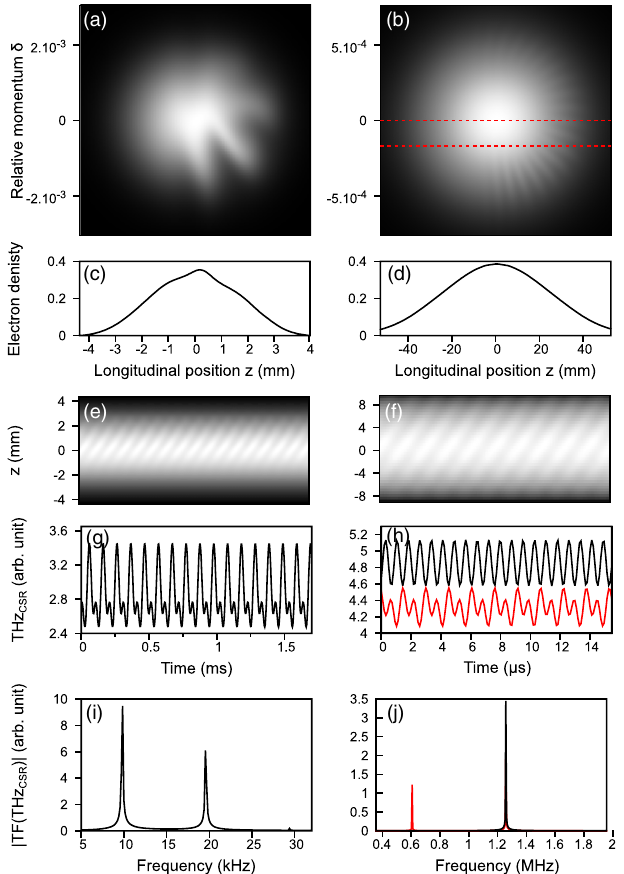
FIG. 1 (color online). From microstructures in the electron- bunch longitudinal phase space f ð z; p; t Þ to modulation of the ð t Þ . Numerical results with (a), (c), (e), (g), THz CSR power P CSR and (i) SOLEIL parameters and (b), (d), (f), (h), and (j) UVSOR II parameters. (a) and (b) Electron bunch phase space f ð z; p; 0 Þ at the time t ¼ 0 . (c) and (d) Associated longitudinal charge density ρ ð z; 0 Þ . (e) and (f) Time evolution of ρ ð z; t Þ . (g) and (h) Asso- ð t Þ . (i) and (j) Norm of the Fourier ciated THz power P CSR ð t Þ : (black line) calculated from all the 2D transform of P FIG. 2 (color online). Angle φ calculated from the Eq. (6) (in CSR phase-space distribution, (red line) calculated from the 2D red) superposed to the numerical phase space (in grey scale). (a) distribution, where − 0 . 5 < p < 0 (distribution between the red and (b) SOLEIL case and (c) and (d) UVSOR II case. (a) and dashed lines in (b). In (h), the red line is shifted vertically for (c) Cartesian ð q; p Þ coordinates and (b) and (d) polar ð r; θ Þ figure clarity. coordinates (same parameters as Fig.